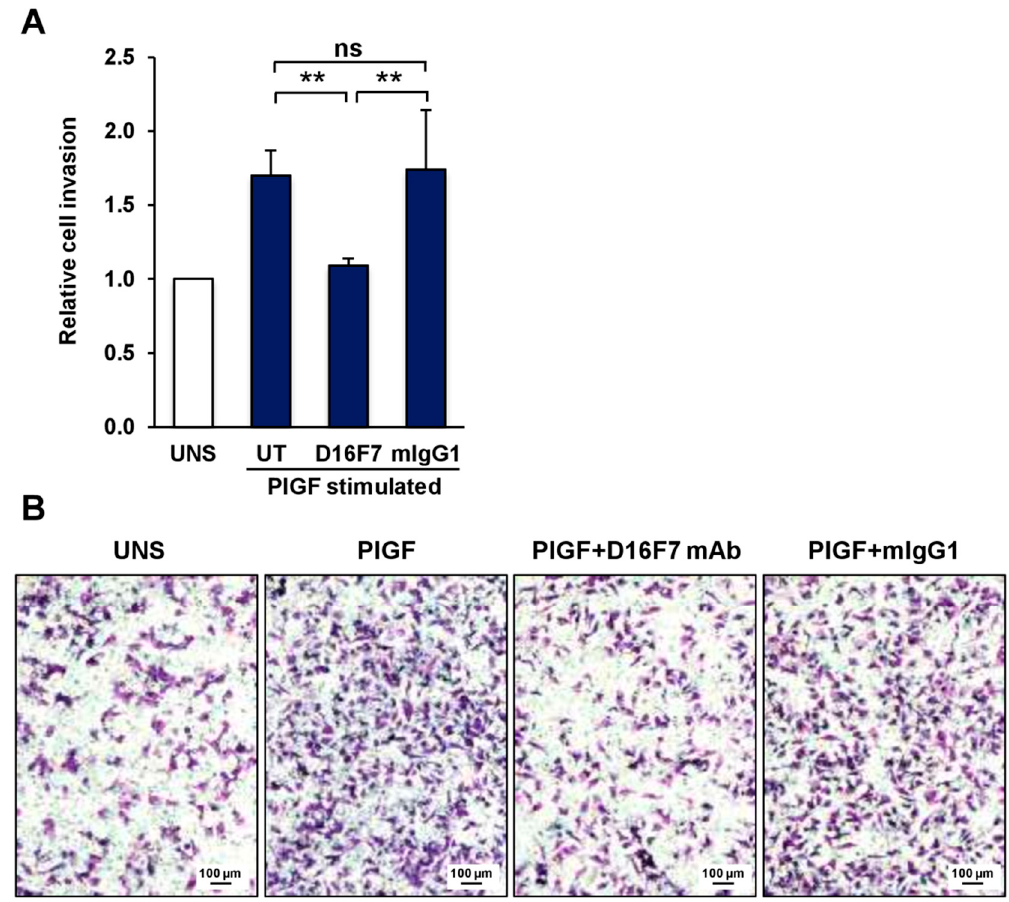
Figure 1. The anti-VEGFR-1 D16F7 mAb inhibits the ability of murine melanoma cells to invade the ECM in response to PlGF. ( A ) The ability of B16F10 cells to invade the ECM upon murine PlGF stimulation (50 ng/mL) in the absence (UT, untreated cells) or presence of 5 μ g/mL of D16F7 mAb or control mouse IgG mAb (mIgG1) was analyzed in Boyden chambers equipped with Matrigel- coated filters (5 × 10 4 cells/chamber, 2 h incubation). The number of invading cells was counted as indicated in the Materials and Methods section, and the results for PlGF-stimulated cells were expressed as relative invasion with respect to the control, unstimulated cells (UNS). The histogram represents the arithmetic mean values ± SD of 5–7 chambers for each experimental condition from three independent experiments. Statistical analysis was performed by Kruskal–Wallis test, followed by Dunn’s post hoc analysis: **, p < 0.01; ns, not significant. ( B ) Representative photographs of invaded cells are shown (100× magnification). Scale bars represent 100 μ m.